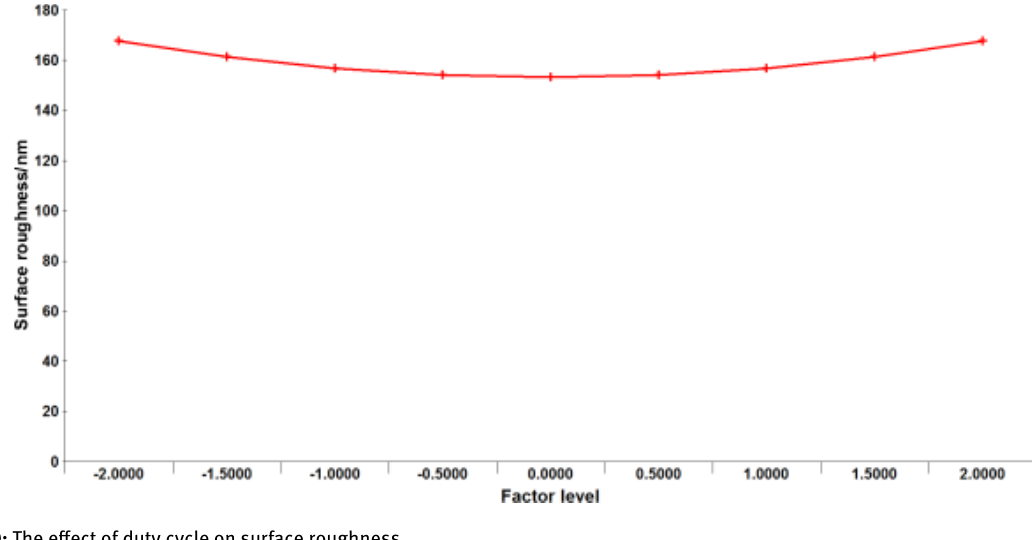
(3) Analysis of the influence of duty ratio on surface